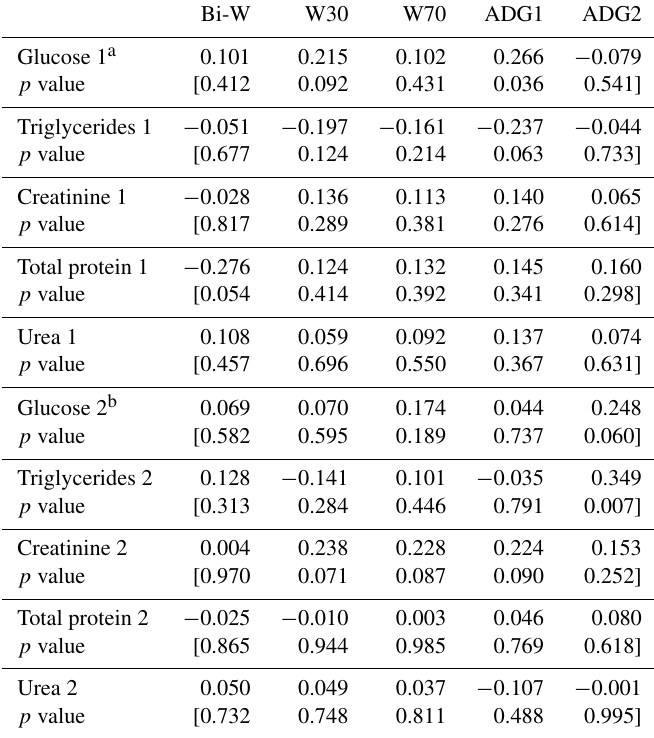
Different superscripts means differences between groups. Table 8. Correlation coefficients among lamb growth parameters and metabolic profile parameters.